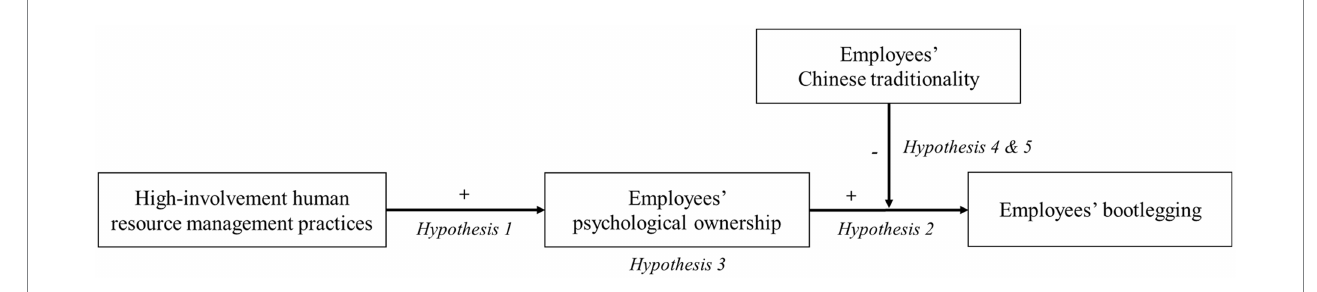
FIGURE 1 Theoretical model. “+” and “ − ,” respectively, represent the positive and negative